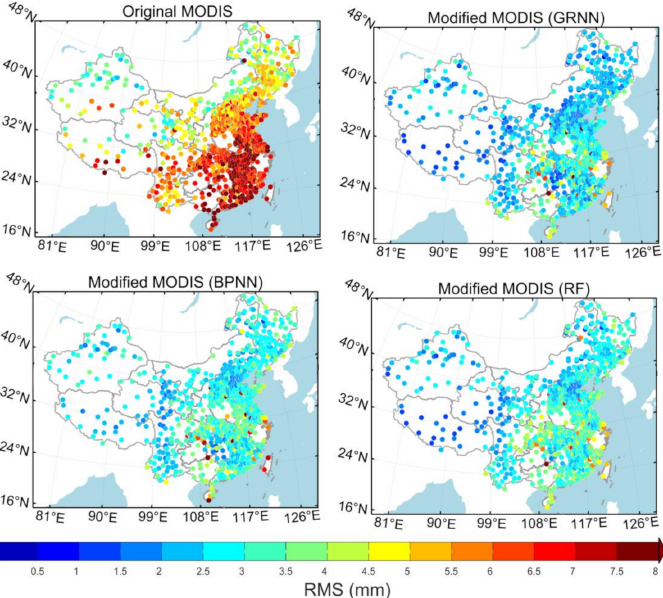
Figure 10. PWV RMSs at GNSS sites which are based on monthly model